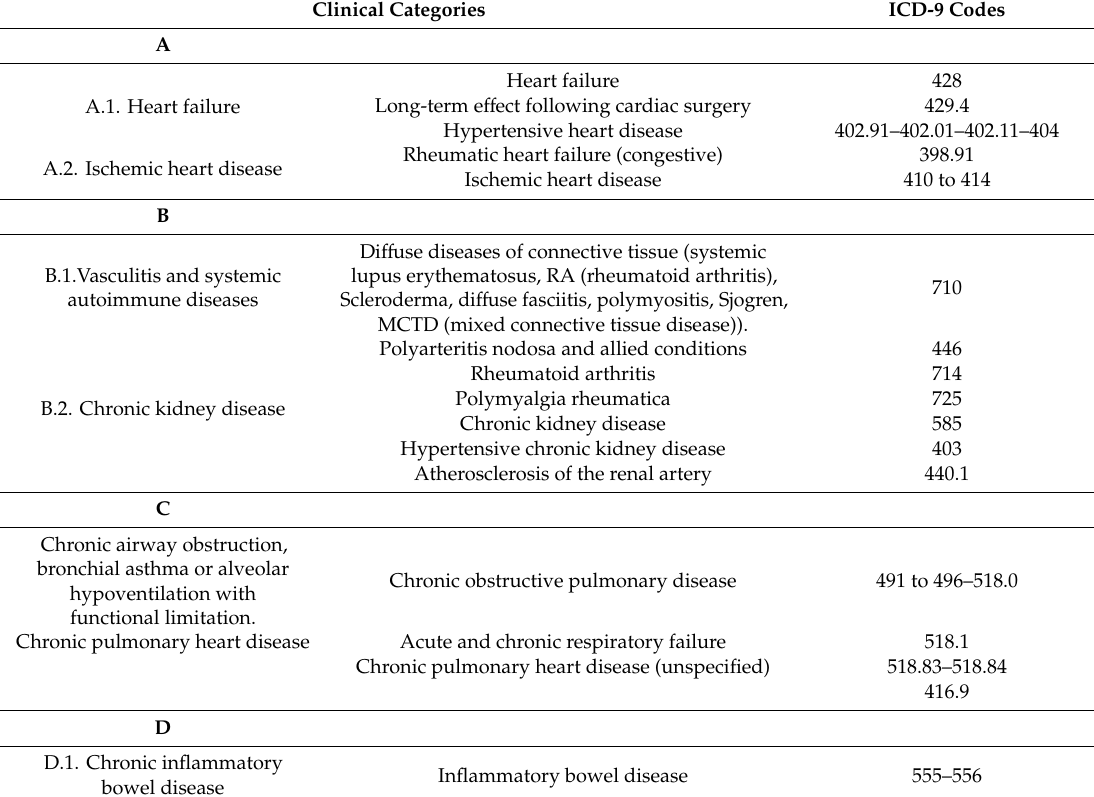
Table 1. Defining clinical categories of polypathological patients (PP) and ICD-9-CM